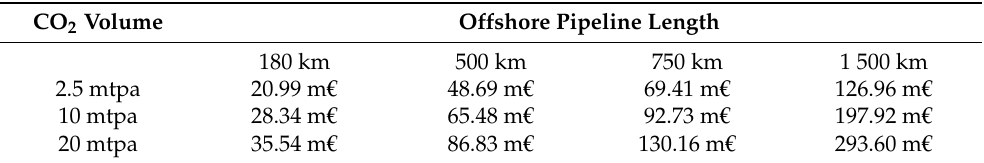
Table 12. Offshore pipeline annuities.